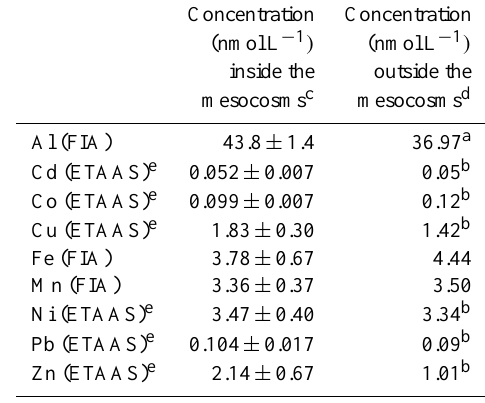
Table 1. Trace metal concentrations before the start of the experi- ment.